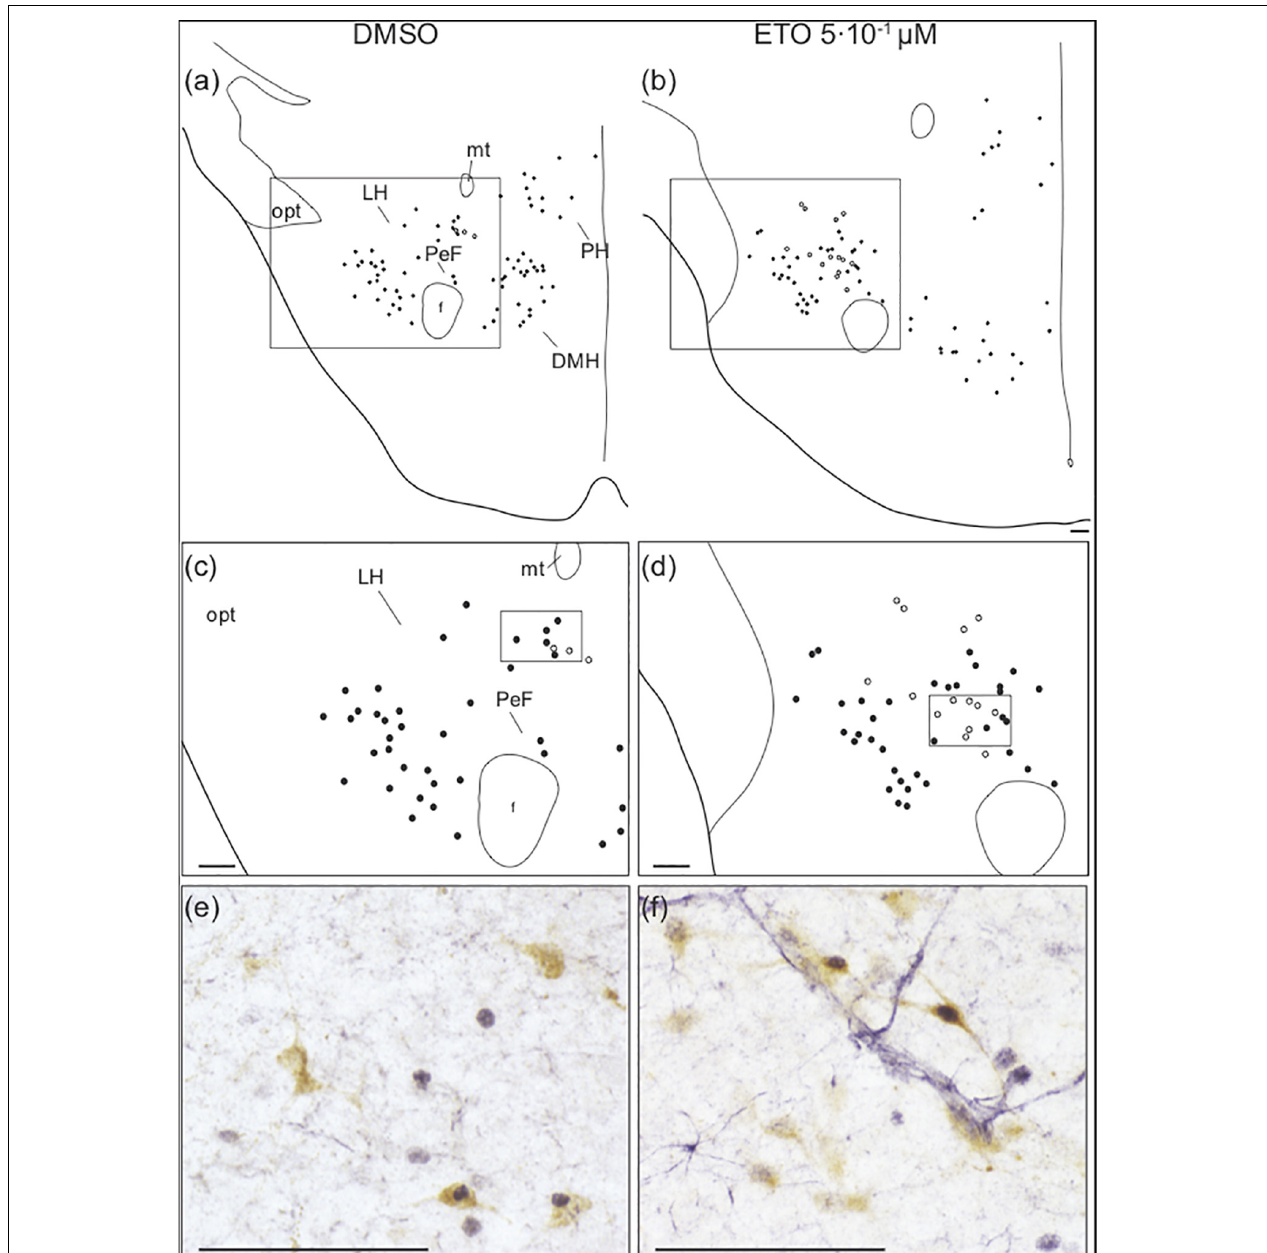
FIGURE 5 | Prolonged metabolic acidosis induced c-fos expression was increased in orexin neurons of caudal hypothalamus by etonogestrel. Drawings showing distribution of cells immunoreactive for c-FOS (black points) and both c-FOS and orexin (white points) in caudal hypothalamus under DMSO (a,c) or 5 · 10 − 1 µ M etonogestrel (b,d) exposure. Drawings in panels (c,d) represent an enlargement of black rectangle in panels (a,b) , respectively. Photomicrographs illustrating metabolic acidosis-induced c-FOS (blue-gray) and orexin (brown) immunoreactivities under DMSO (e) and 5 · 10 − 1 µ M etonogestrel (f) exposure. Photomicrographs correspond to regions outlined by black rectangles in panel (c) for (e) and in panel (d) for (f) . Scale bar = 100 µ m. Abbreviation: dorsomedian hypothalamic nucleus (DMH), etonogestrel (ETO), fornix (f), lateral hypothalamic area (LH), mamillothalamic tract (mt), optic tract (opt), perifornical area (PeF), posterior hypothalamic area (PH), and third ventricule